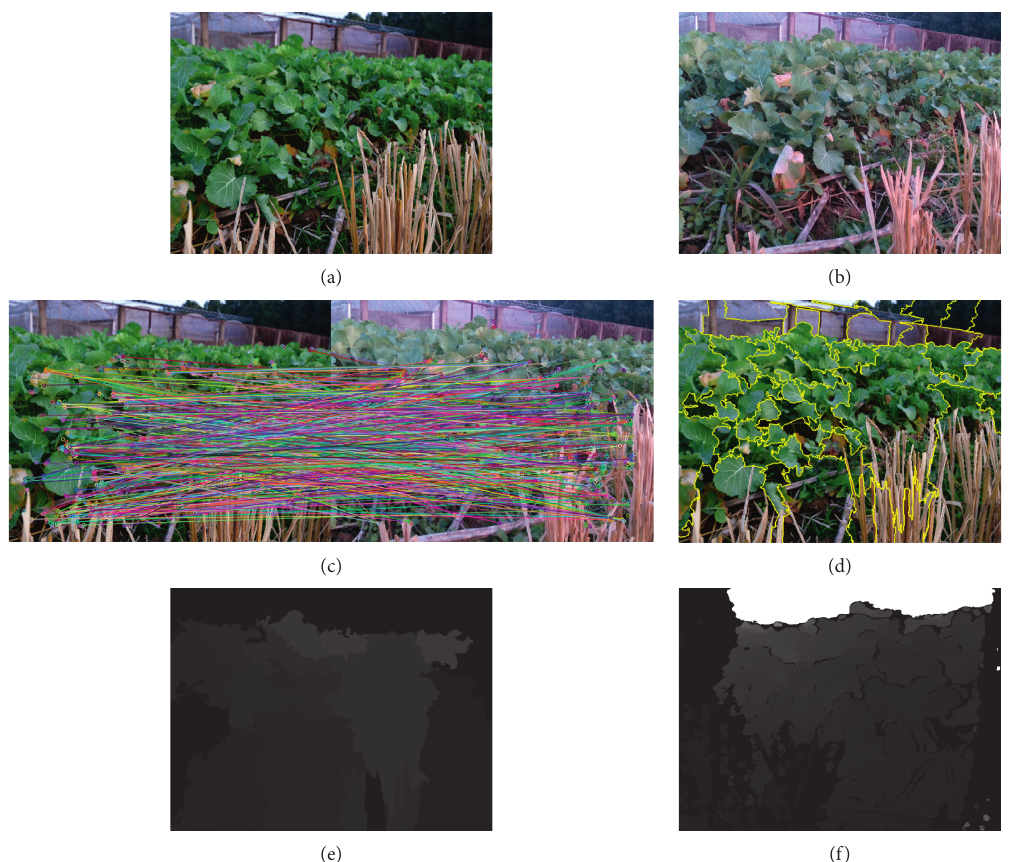
Figure 6: Algorithm test results. (a) The RGB image captured by Nikon D7500. (b) The RGB image captured by RealSense D415. (c) The feature point matching result. (d) Superpixel segmentation results. (e) The depth map generated by the algorithm in this paper. (f) Depth map taken by depth